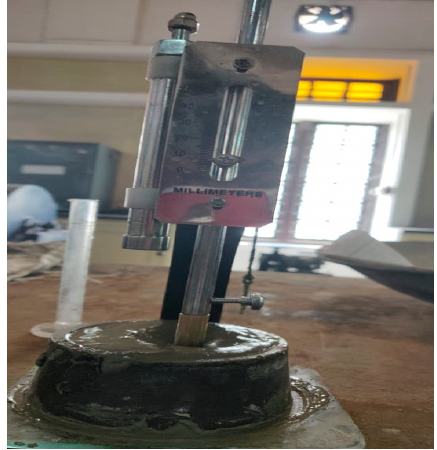
Figure 3. Vicat’s mould apparatus setup on consistency test of cement paste.